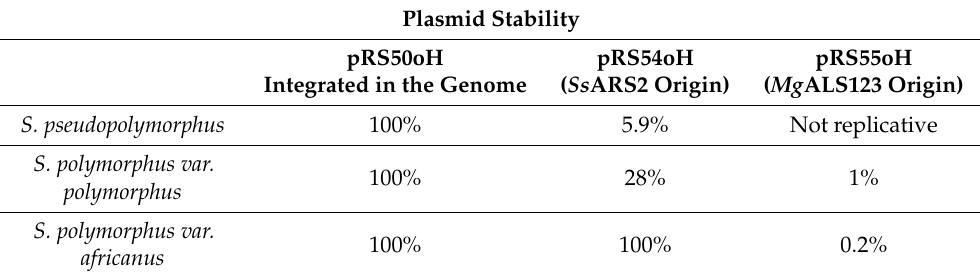
Table 4. Stability of replicative plasmids pRS45oH ( Ss ARS2), pRS55oH ( Mg ALS123) and pRS50oH plasmid integrated into the genome (control) in yeasts belonging to the Schwanniomyces genus. The plasmid stability is determined as a percentage of cells resistant to hygromicin B after cultivation till stationary phase under hygromicin selective